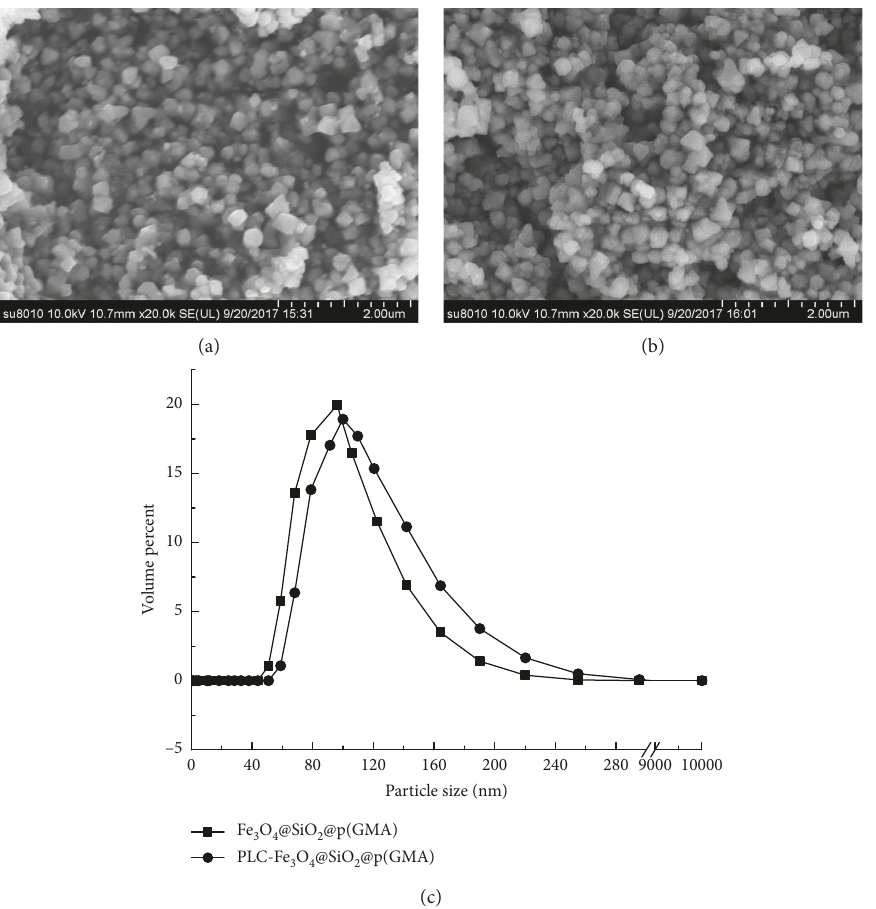
Figure 3: Scanning electron microscopy images of particles prepared and particle size analysis. In (a), the ballability of Fe p(GMA) was good and the average size was 90nm. In (b), SEM micrographs of PLC-Fe 3 O 4 @SiO 2 @p(GMA) also had a good ballability and the average particle size was about 105nm. The average particle size of Fe 3 O 4 @SiO 2 @p(GMA) was 96.70 ± 1.00nm, and the particle size distribution range was 55 to 255 nm. For PLC-Fe 3 O 4 @SiO 2 @p(GMA), the average particle size was 99.86 ± 0.80nm and 90% of the particles were in the range of 58 to 295nm. (a) Fe 3 O 4 @SiO 2 @p(GMA). (b) PLC-Fe 3 O 4 @SiO 2 @p(GMA). (c) Particle size